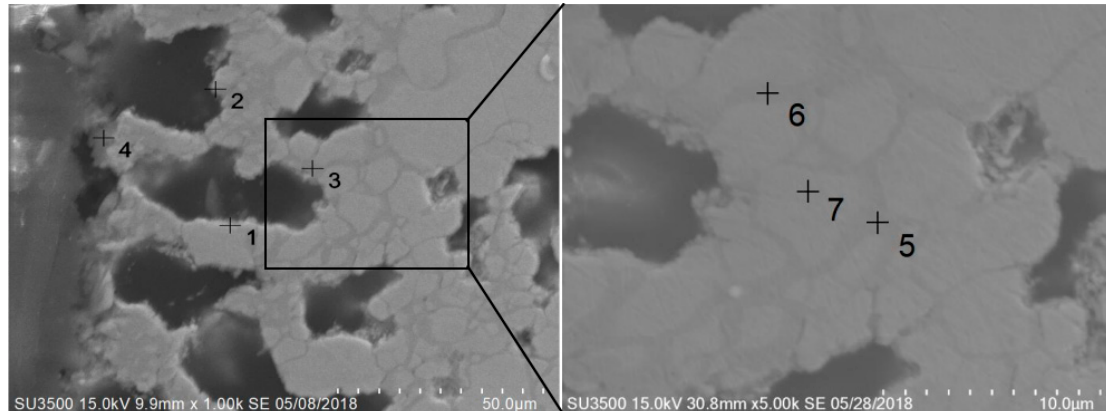
Figure 7. Cross-section of IrRh25 after oxidation. Table 5. EDS analysis results of IrRh25 after oxidation at cross-section.